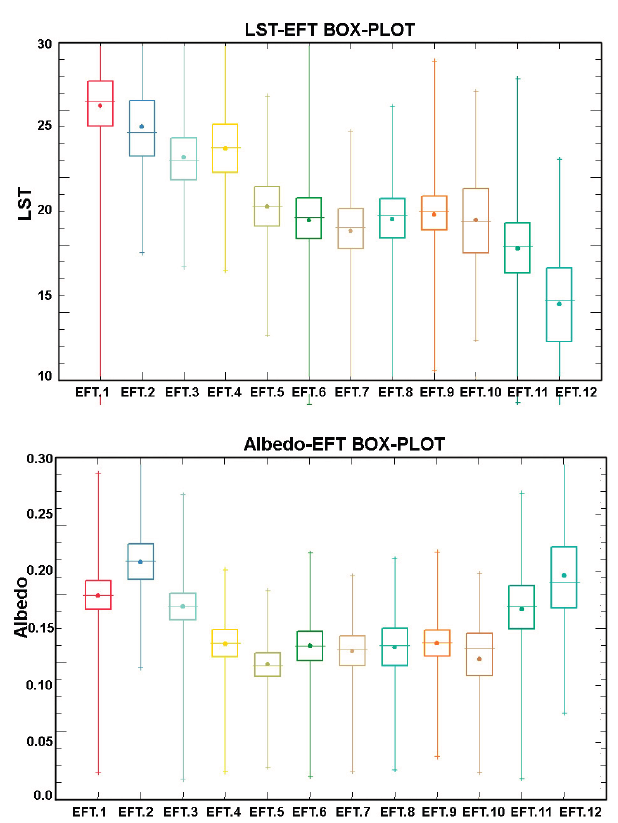
Figure A. Box-plots of the three ecosystem function variables (LST, Albedo and NDVI) for the twelve